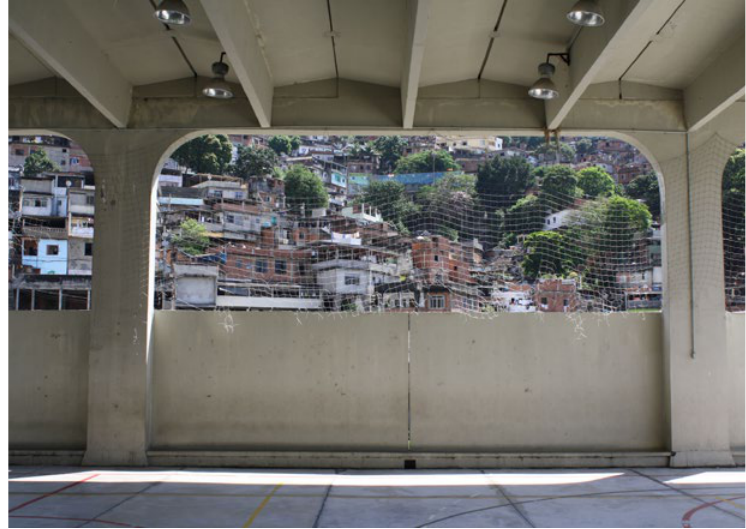
Figure 8 The multipurpose room on the rooftop at CIEP Doutor Antoine Magarinos Torres Filho, a compact-designed CIEP. Image © Aberrant